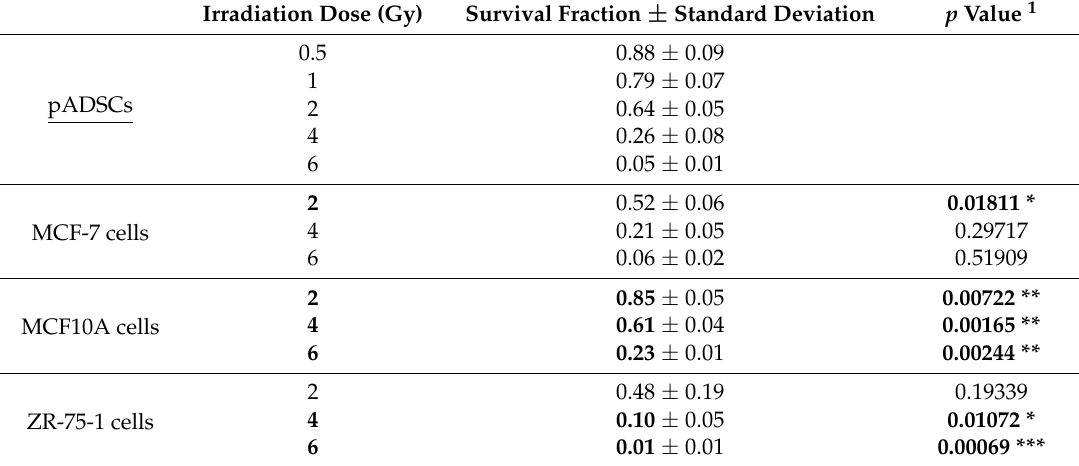
Table A1. Comparison of pADSC survival fractions for each dose with those of MCF-7, MCF10A, and ZR-75-1